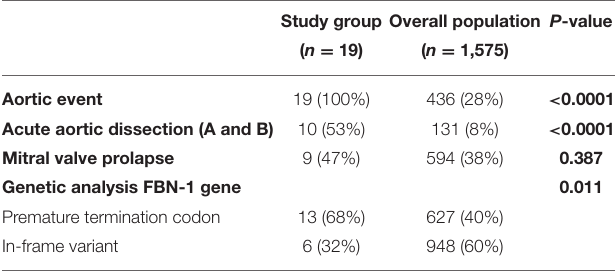
TABLE 4 | Comparison of the study group ( n = 19) and overall population ( n = 1,575).